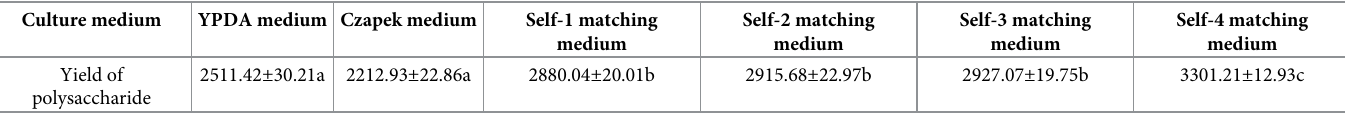
Table 2. Effect of five fermentation media on the MRYP yield (mg/L).